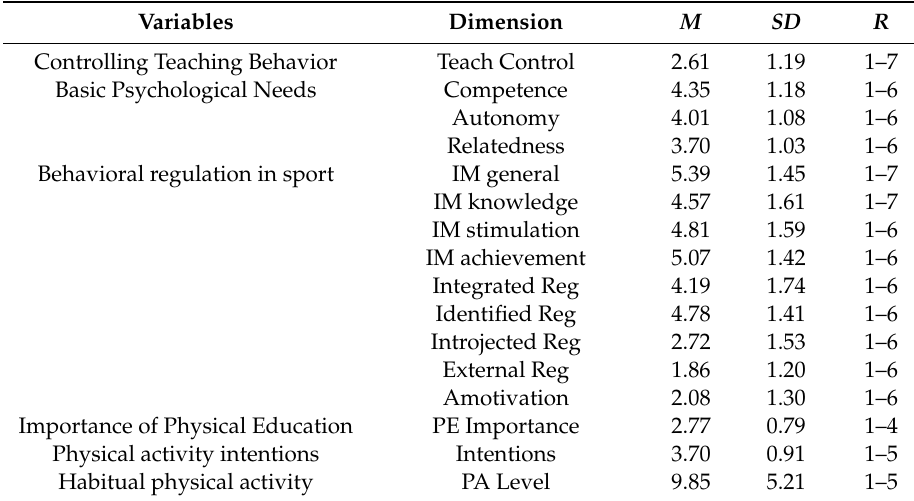
Table 1. Descriptive statistics among study